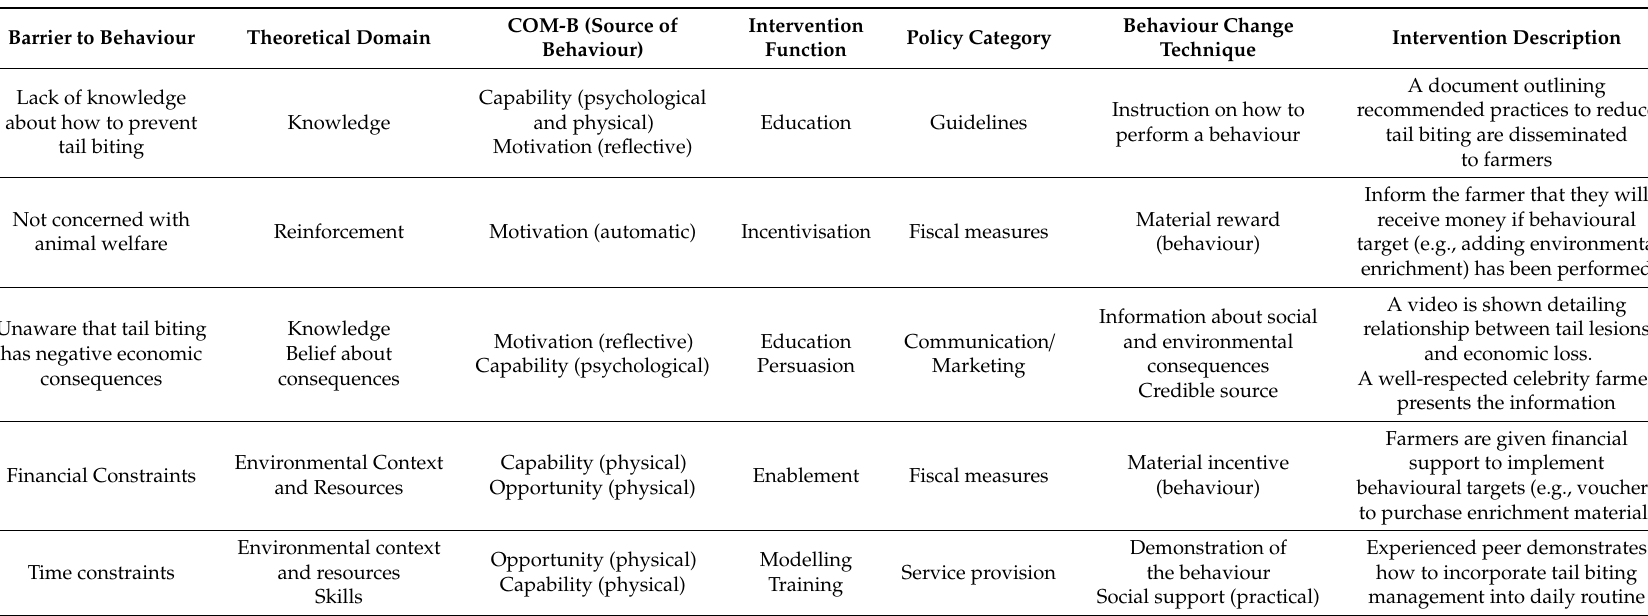
Table 2. Applying principles from the Behaviour Change Wheel [53], the Theoretical Domains Framework [52] and the Behaviour Change Techniques Taxonomy [54] to design a behavioural intervention for farmers to reduce tail biting among their